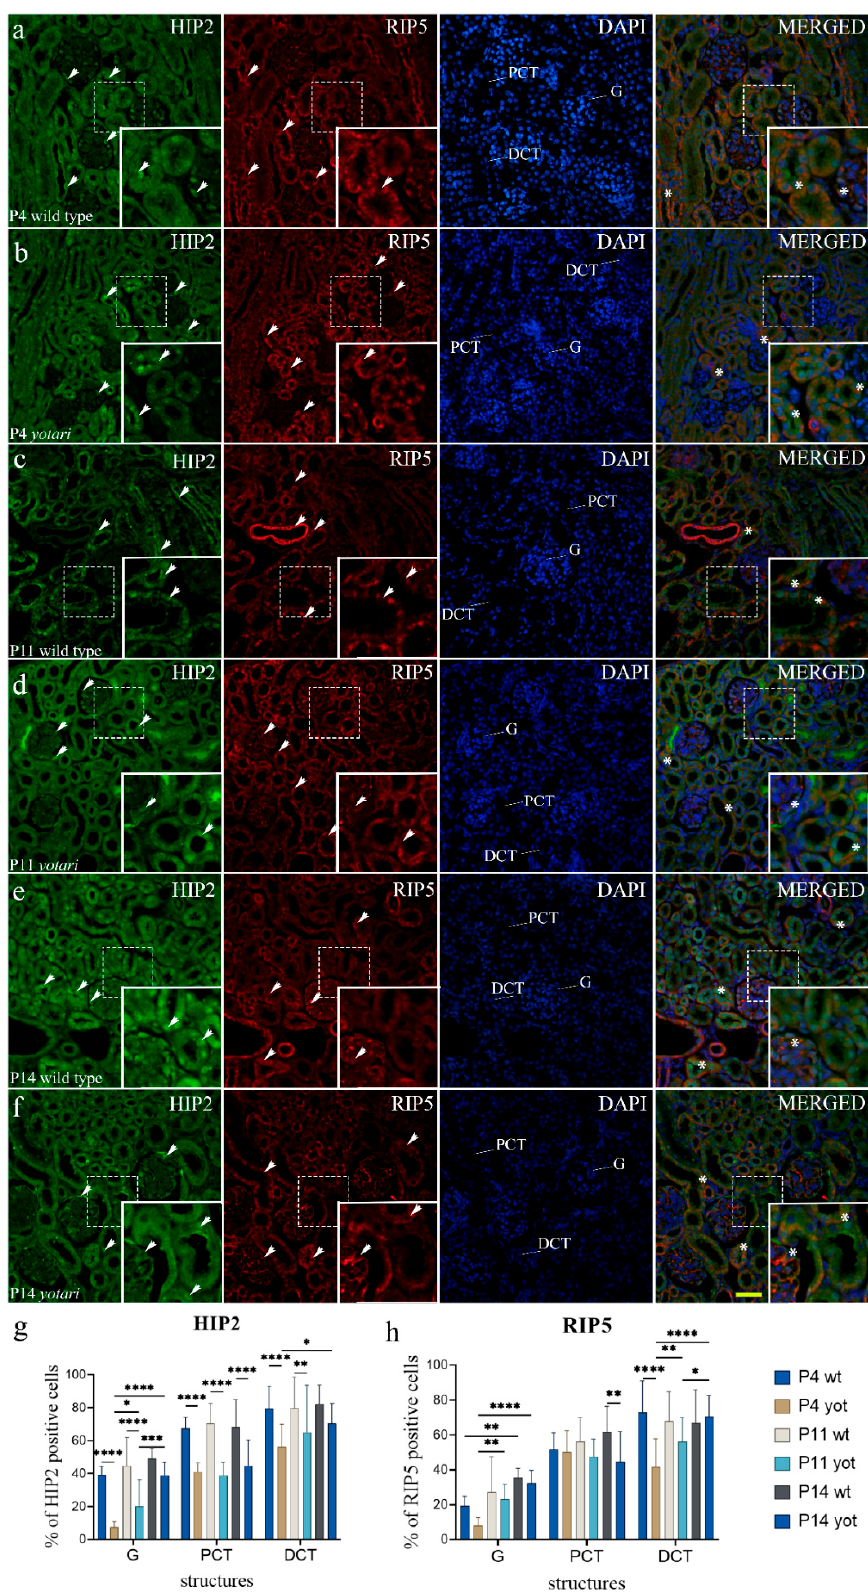
Figure 4. Double immunofluorescence staining of postnatal wild-type and yotari mice kidneys with the HIP2 and RIP5 markers ( a – f ). Arrows indicate the expression pattern of HIP2 and RIP5 in glomeruli (G), proximal convoluted tubules (PCT), distal convoluted tubules (DCT). Immunoexpression of HIP2, RIP5, 4 ′ ,6-diamidino-2-phenylindole (DAPI) staining and merged